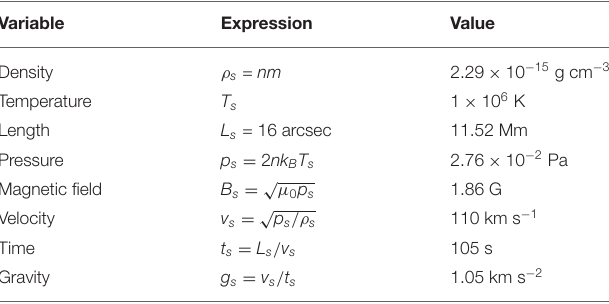
TABLE 1 | Parameters used for